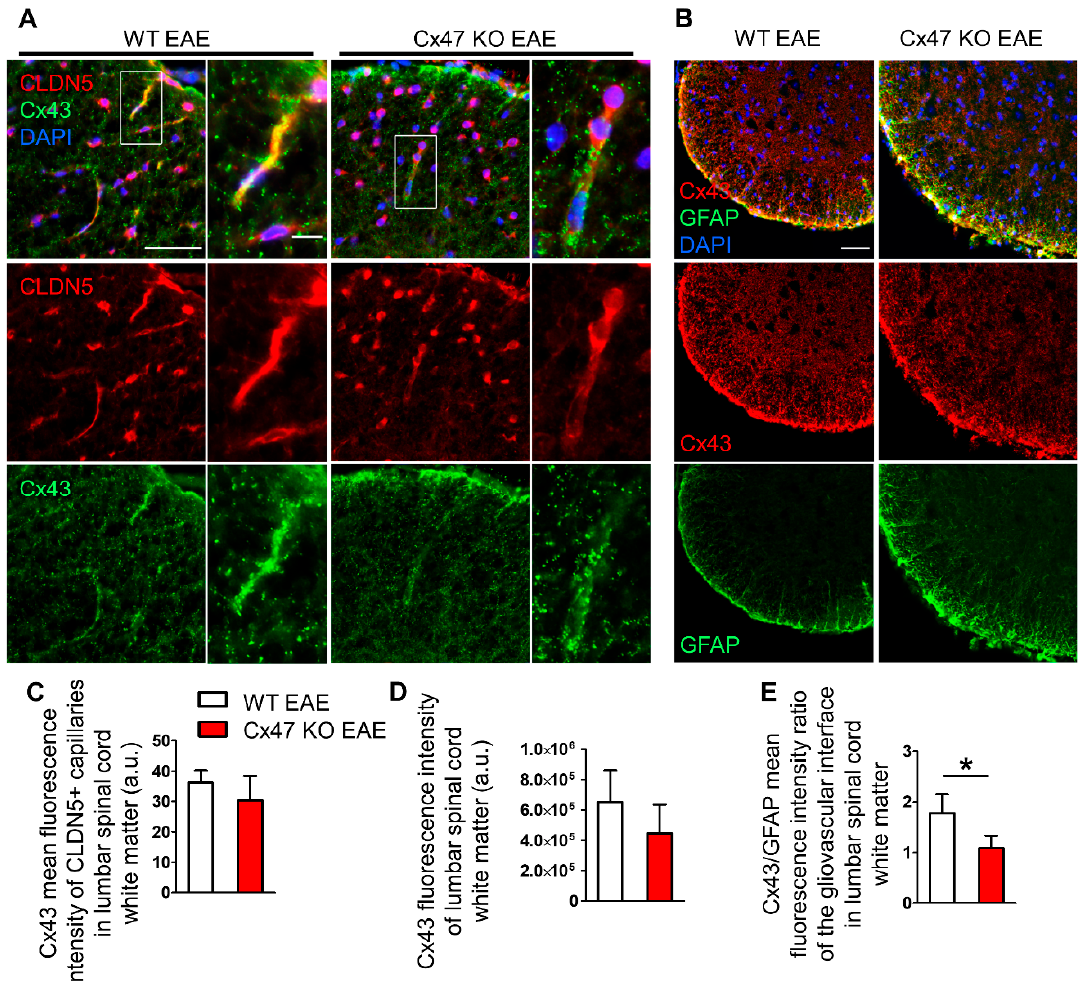
Figure 7. Cx43 immunoreactivity at the glio-vascular interface and lumbar spinal cord white matter of Cx47 KO and WT EAE mice at 7 dpi. ( A ) Representative immunofluorescence images of lumbar spinal cord cross sections from a WT and Cx47 KO EAE mouse (both with a clinical score of 0) at 7 dpi (Scale bar = 50 μ m). Tissues were stained with antibodies against the endothelial TJ protein CLDN5 (red) and Cx43 (green). Nuclei are counterstained with DAPI (blue). Single channels and overlap images are provided. Magnified views from rectangular boxes are depicted on the right (Scale bar = 10 μ m). ( B ) Cross sections of the anterolateral lumbar spinal cord region from a WT and Cx47 KO EAE mouse (both with a clinical score of 0) at 7 dpi immunostained for Cx43 (red) and GFAP (green) show reduction of Cx43 in the Cx47 KO (Scale bar = 50 μ m). ( C ) Semi-quantitative analysis of ( A ), where mean intensity of Cx43 fluorescence overlapping with the vessel-like CLDN5 fluorescence pattern ( n = 9–11 vessels/mouse) was assayed with ImageJ from the lumbar spinal cords of n = 4 WT EAE mice and n = 4 Cx47 KO EAE mice. ( D ) Semi-quantitative analysis of ( B ), where six 4 cm × 4 cm regions of interest (ROI) from the anterolateral white matter region were drawn from one image per WT EAE ( n = 4, clinical score of all mice was 0) and per Cx47 KO EAE mouse ( n = 4, clinical score of all mice was 0). ( E ) Perivascular Cx43 mean fluorescence intensity from each mouse was divided by their respective perivascular GFAP mean fluorescence intensity. a.u., arbitrary units. Data are presented as mean ± SD. Unpaired student’s t -test was used for all comparisons: * p < 0.05. Scale bar = 50 µ m; Magnified view scale bar = 10 µ